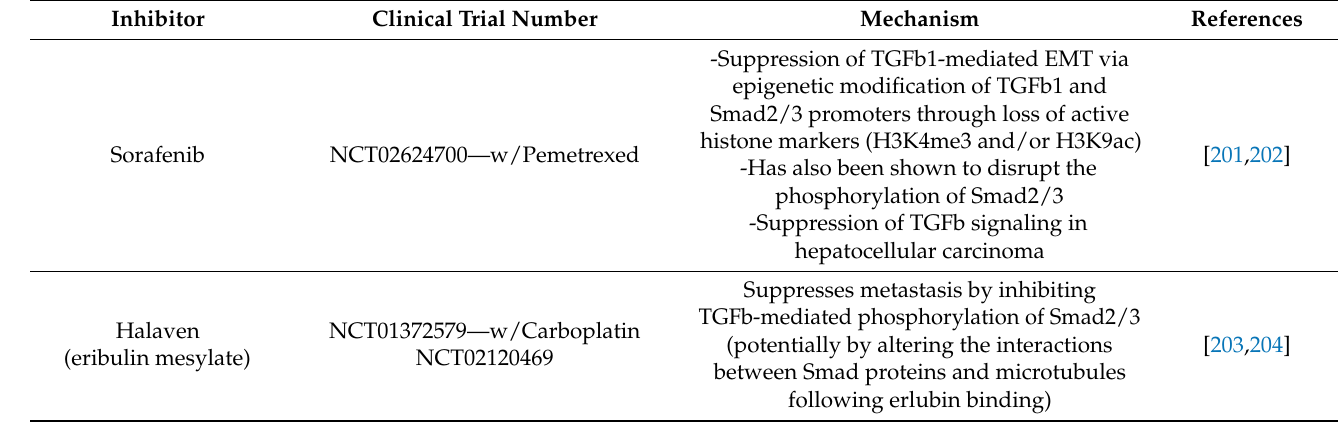
Table 2. Potential TGF- β inhibitors in active TNBC clinical trials. The Clinicaltrials.gov database was used to assess active interventional clinical trials for TNBC treatment within phase 1, 2, 3, or 4 of